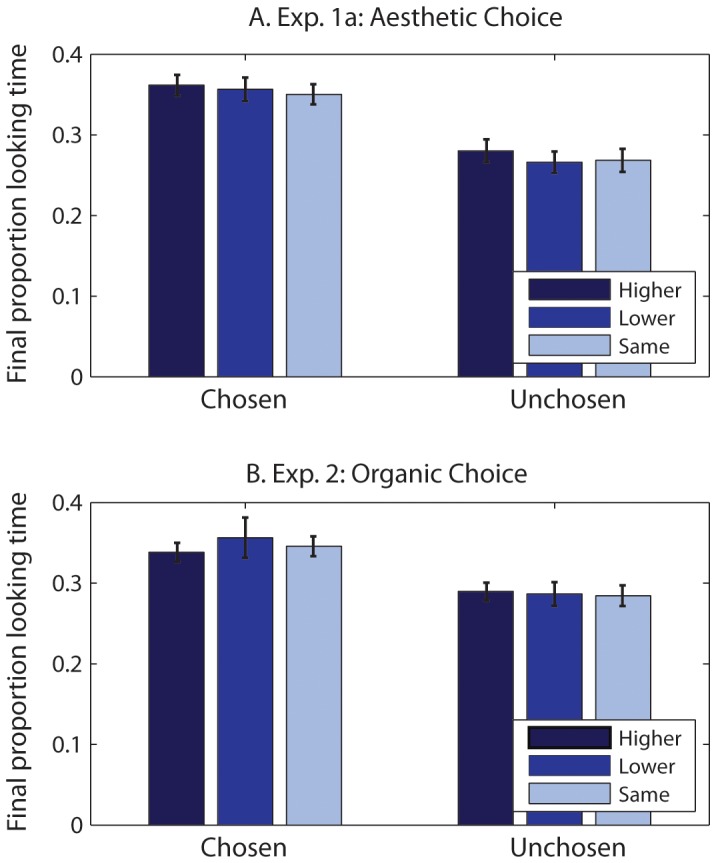
Final proportional looking times for chosen and unchosen items for trials in which the chosen item had a higher baseline rating (dark blue), the chosen item had a lower baseline rating (medium blue), and the two items had the same baseline rating (light blue).A greater proportion of the total fixation duration was on the chosen item across all differences in baseline ratings.